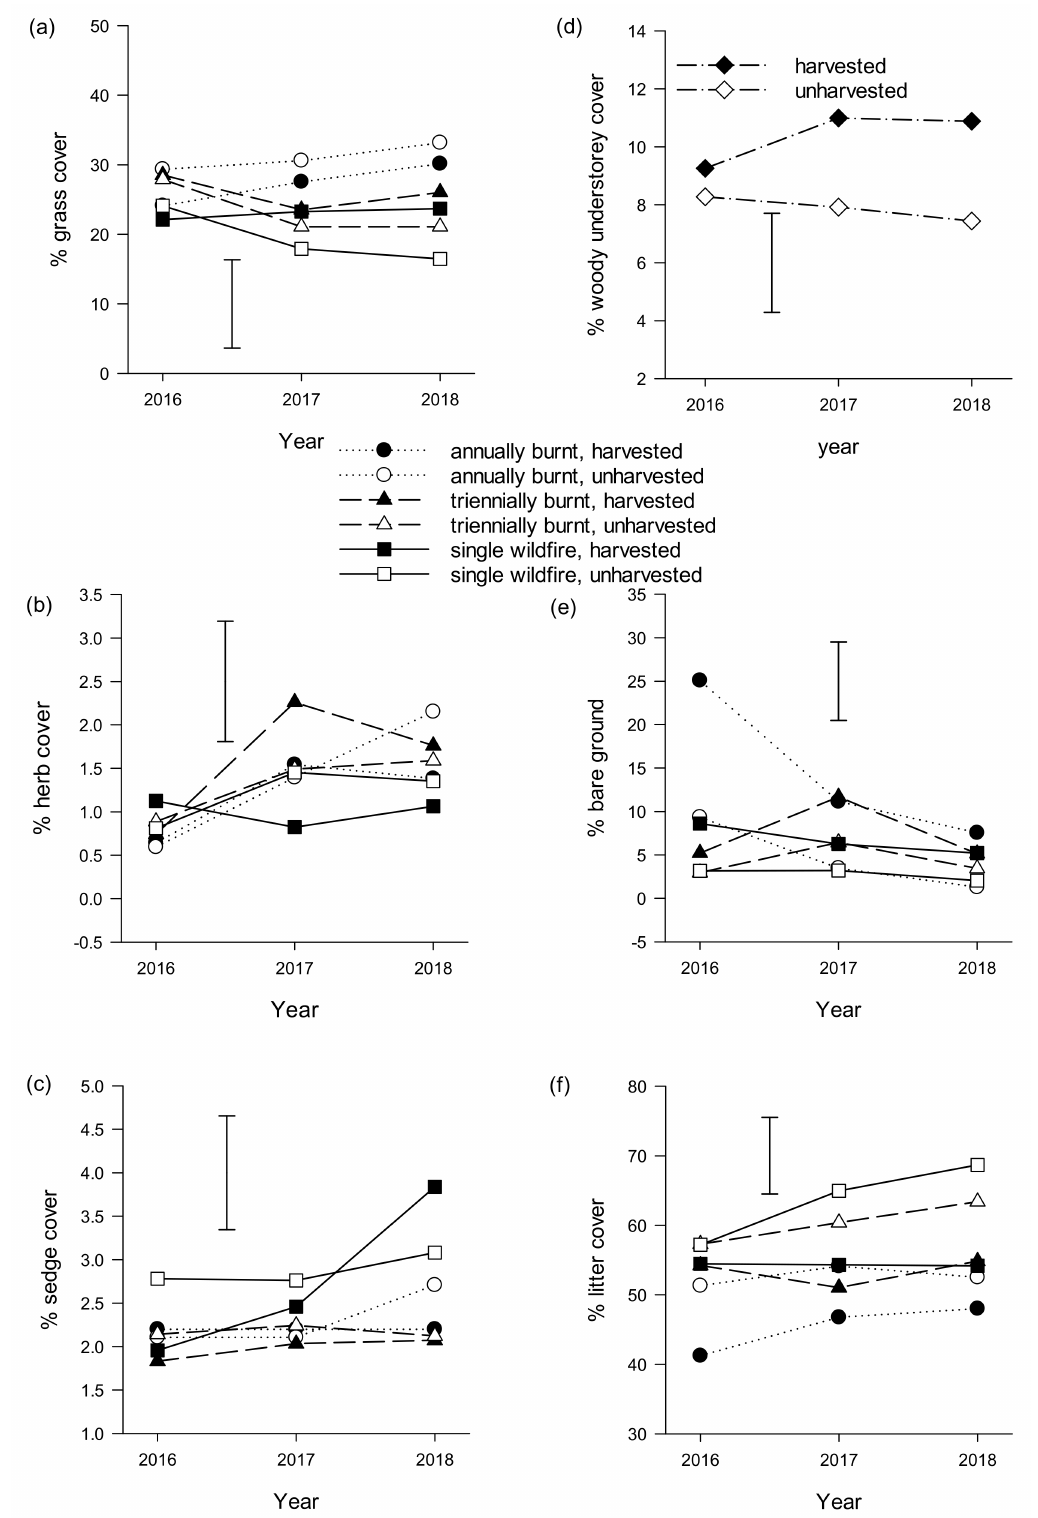
Figure 3. Variation in mean percentage cover of different attributes over time in harvested and unharvested transects. There were significant time × fire treatment × harvesting interactions for: ( a ) perennial grasses, ( b ) herbs, ( c ) sedges, ( e ) bare ground and ( f ) leaf litter; and a significant time × harvesting interaction for woody plant understorey cover ( d ). Prescribed burns took place in 2015 in the annually burnt treatment and 2016 in the triennially burnt treatment. The error bar indicates the